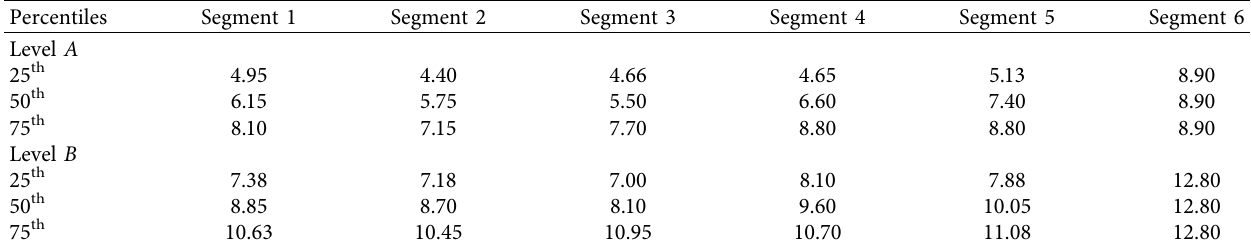
Table 2: Thickness of mandible at levels A and B in edentulous patients.